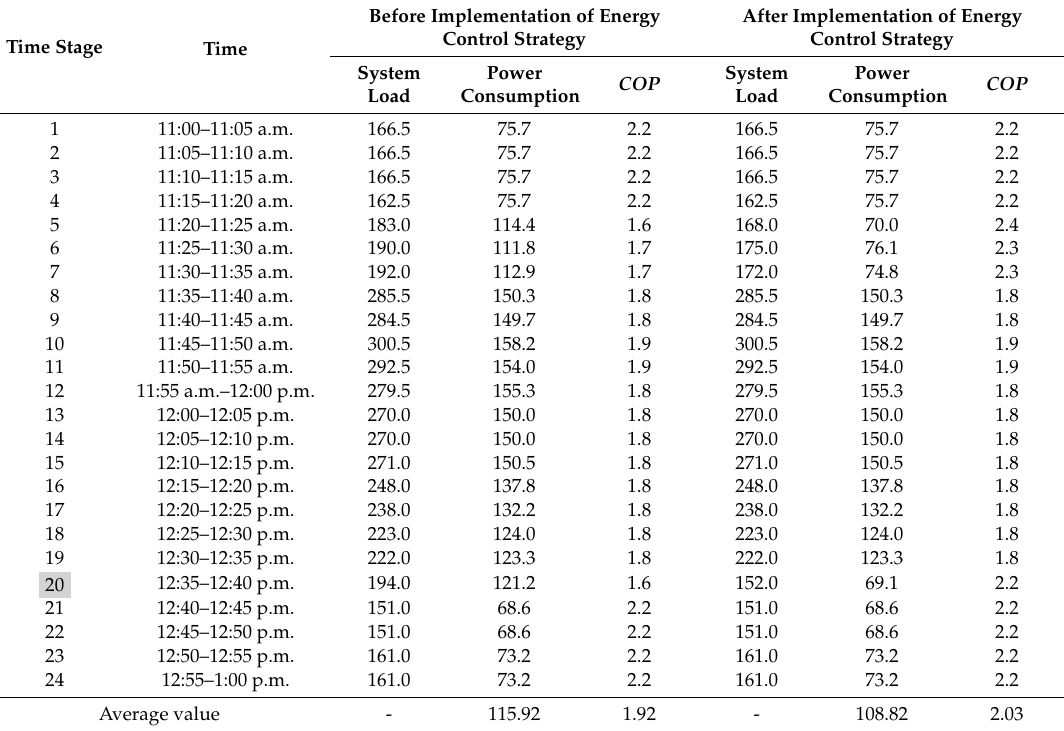
Table 6. The comparison among system load, power consumption, and coe ffi cient of performance ( COP ).